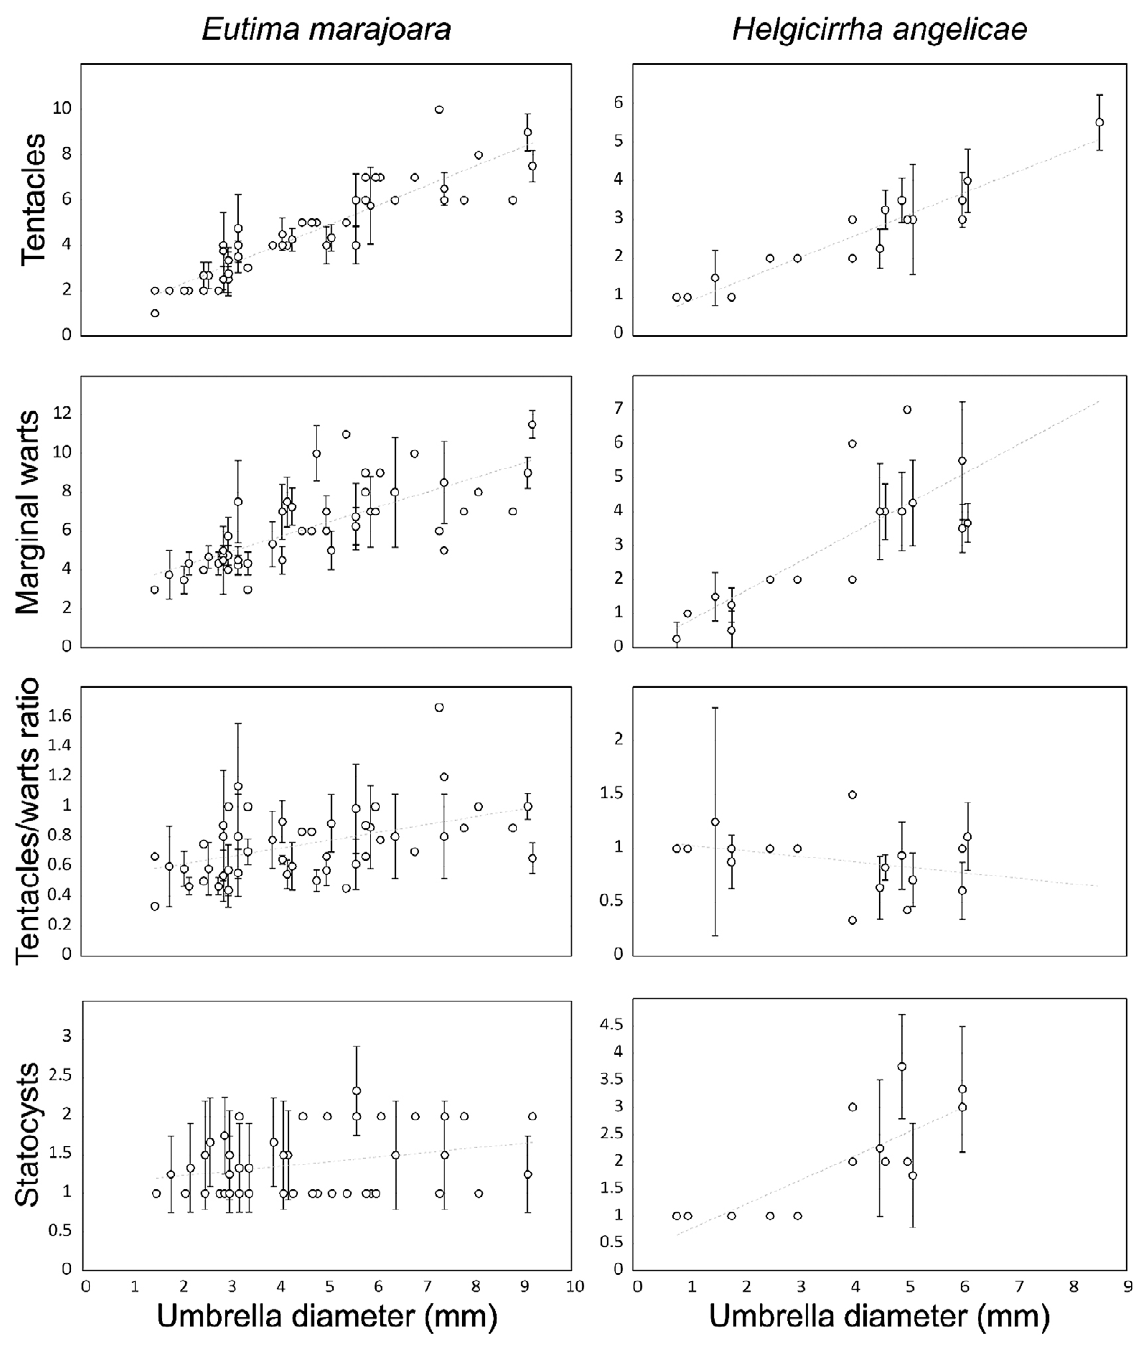
Fig. 3. – Eutima marajoara n. sp. and Helgicirrha angelicae n. sp. relationship between mean number of marginal structures per umbrella quadrant and umbrella diameter. Symbols are mean+SD for each individual; symbols without error bars indicate that data from a single quadrant were available; dotted lines are the result of linear regressions (Table